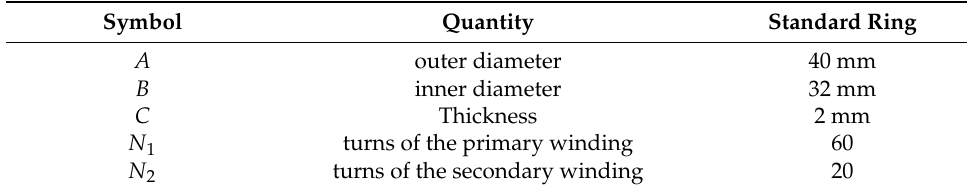
Table 1. Parameters of the tested standard ring